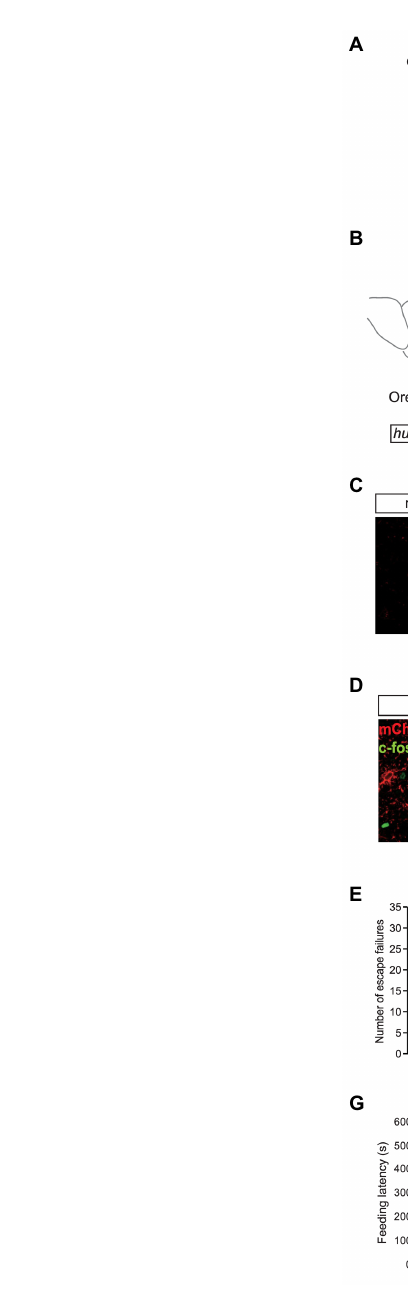
FIGURE 2 Chemogenetic activation of orexinergic neurons induces resilience. (A) Experimental schedule of chemogenetic activation of orexinergic neurons during stress-related behavioral tests [learned helplessness test (LHT): saline, n = 6; CNO, n = 9; FST and novelty suppressed feeding (NSF) test: saline, n = 4; CNO, n = 6]. (B) Schematic diagram of the induction of Cre-dependent hM3Dq expression in the lateral hypothalamic area (LHA) of orexin-Cre mice by viral vector injections. (C) Representative images showing colocalization of hM3Dq (red) and orexin A (green) in the hypothalamus (scale bars indicate 20 μ m; left). The quantitative results are shown in the graph (right). White arrowheads indicate cells coexpressing hM3Dq (red) and orexin A (green). (D) Representative images showing c-fos expression (green) in hM3Dq-expressing cells (red) after saline or CNO injection (scale bars indicate 20 μ m; left). The quantitative colocalization data are shown in the graph (*** p < 0.001, independent t -test; right). White arrowheads indicate cells coexpressing mCherry (red) and c-fos (green). (E) Chemogenetic activation of orexinergic neurons in the second escape test induced a significant decrease in the number of escape failures (* p < 0.05, post hoc paired t -test). (F) Time spent immobile, swimming, or climbing in the FST upon chemogenetic activation (** p < 0.01, independent t -test). (G) The latency to the first feeding in the NSF test was also significantly reduced upon the activation of orexinergic neurons (** p < 0.01, independent t -test). (H) Total food consumption was not different between the CNO-treated and saline- treated groups in the NSF